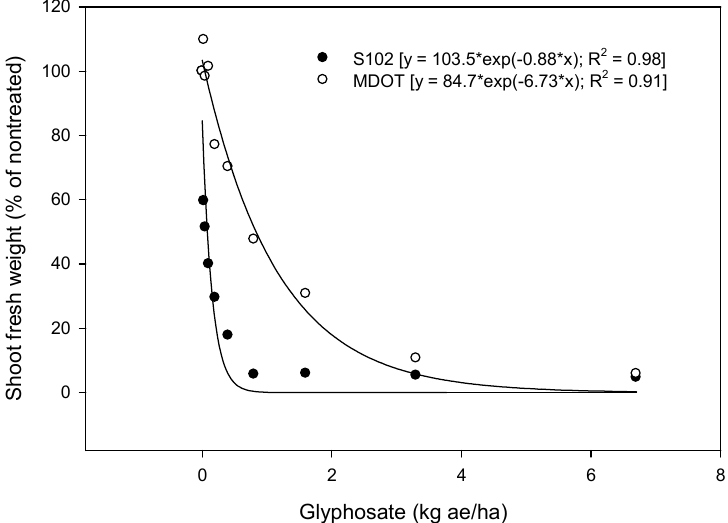
Figure 1. Glyphosate dose response on above ground shoot growth of resistant (MDOT) and susceptible (S102) horseweed populations. GR reduce plant growth by 50%) values for MDOT and S102 populations were 0.78 and 0.066 kg ae/ha glyphosate,